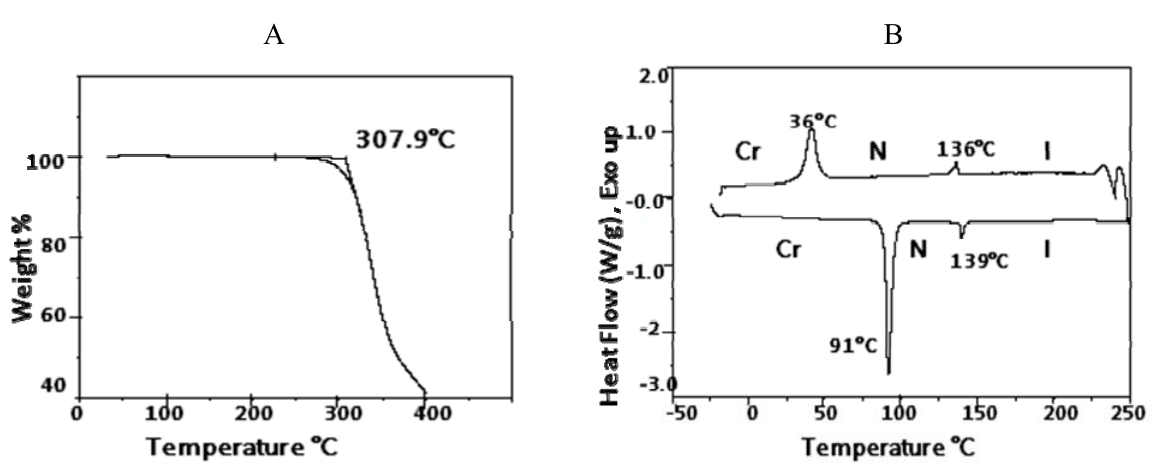
Figure 6. (6A) Thermogravemetric analysis of benzoic acid, 4-(4-pentenyloxy)-, 2-acetyl- 1,4-phenylene ester ( 5 ). (6B) DSC thermograms for benzoic acid, 4-(4-pentenyloxy)-, 2- acetyl-1,4-phenylene ester ( 5 ).